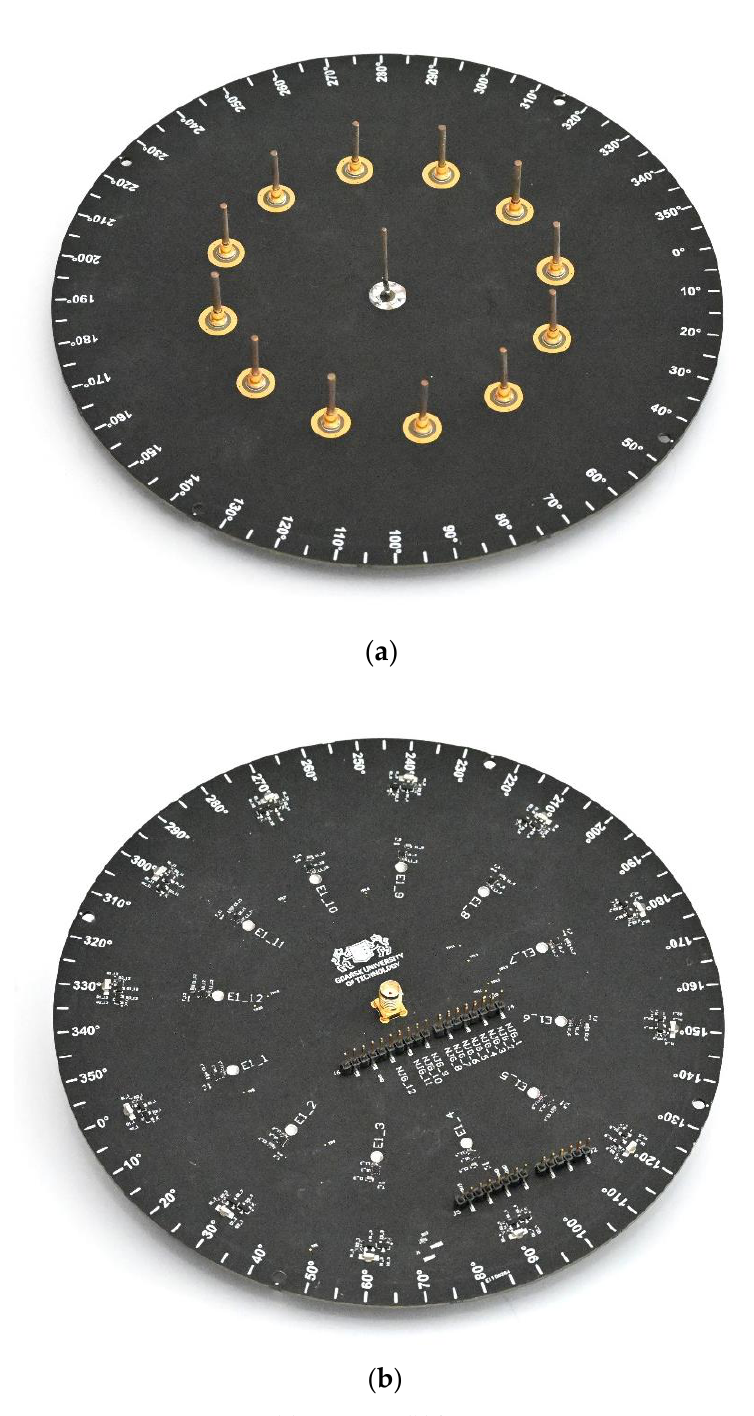
Figure 3. ESPAR antenna: ( a ) top view; ( b ) bottom view.